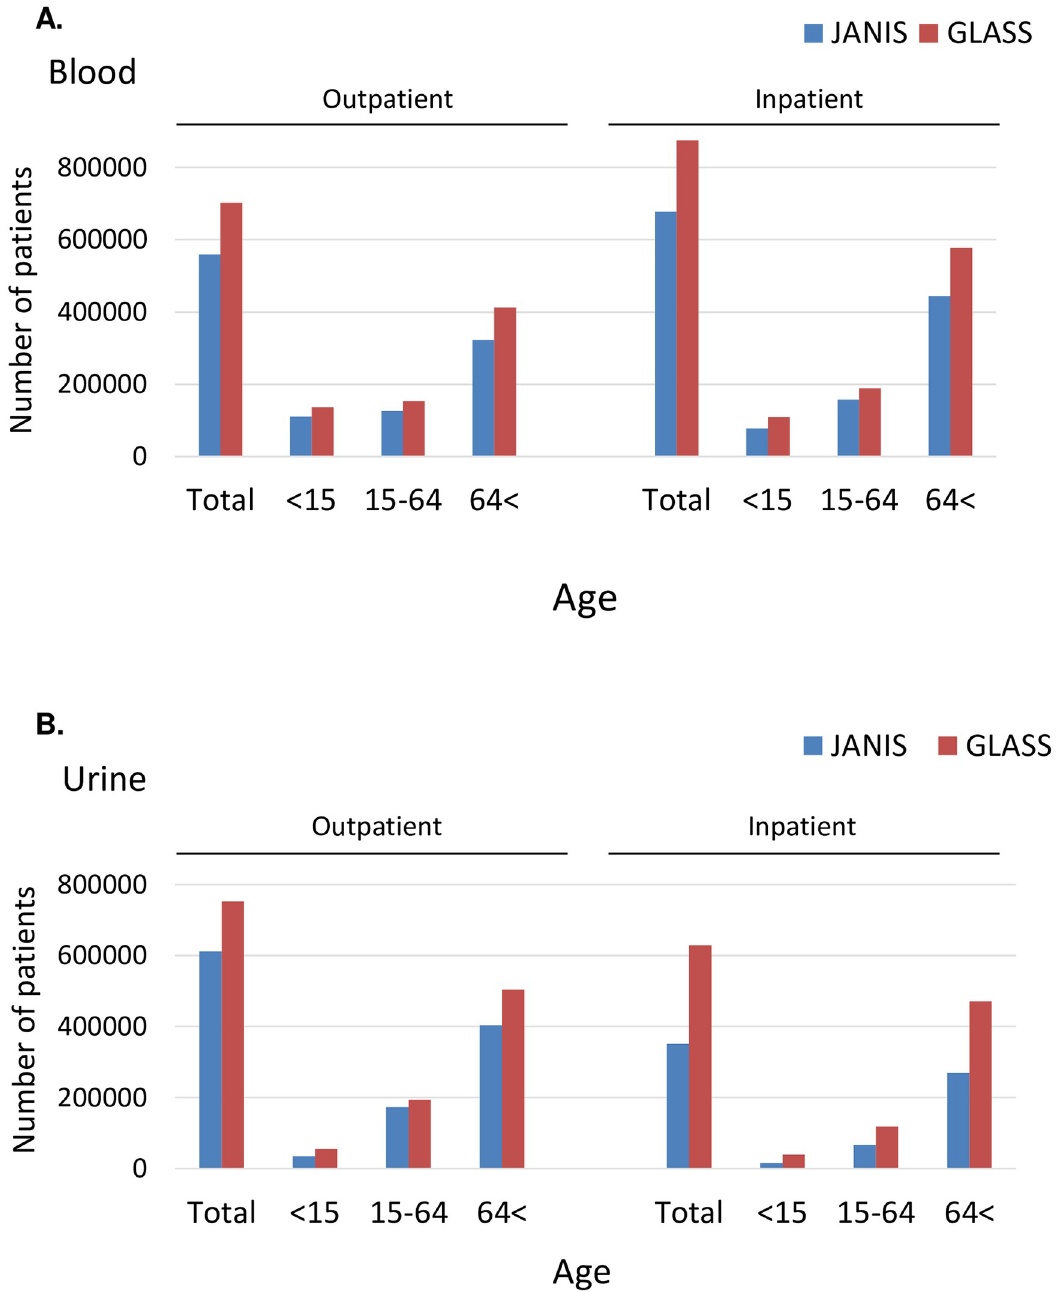
Fig 1. Comparison of the number of patients with samples (blood and urine) collected for bacteriological testing. The value was determined from the tabulated numbers for NUMSAMPLEDPATIENTS in the Sample file required for submission to GLASS and is shown separately for outpatient (left) and inpatient (right). The x-axis denotes age group and “Total” indicates the sum of all three age groups. The blue and dark red bars are the outcomes from JANIS and GLASS, respectively. (A) Blood. (B) Urine. the E . coli urine isolates, the largest difference in resistance was similarly seen in levofloxacin (LVX), with almost 2.7% in outpatients and 2.8% in inpatients (Fig 2C and 2D). Comparison between the method for counting patients and that for counting isolates from JANIS showed that the former (“JANIS (patients)” colored in blue in Fig 2) kept the resistance values more